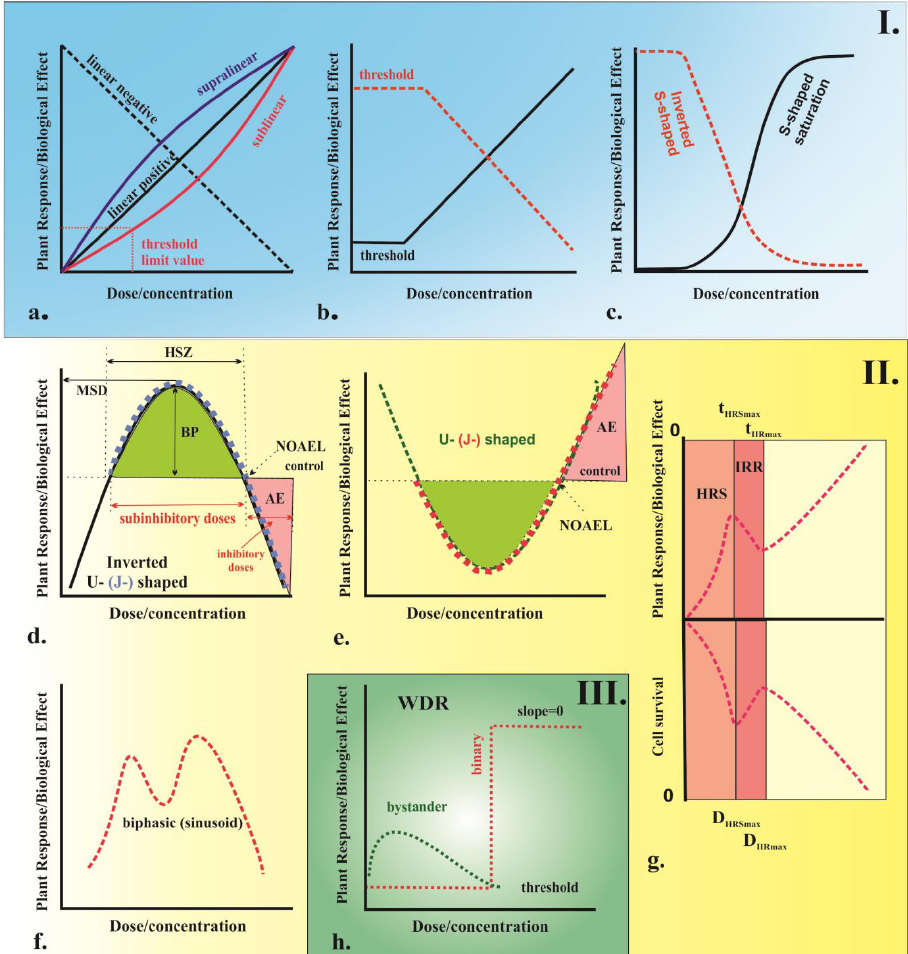
Figure 4. Hypothetical curves of the dose – response relationship. I. Monotonic type (blue background). ( a ) Linear, sublinear and supralinear curves with no clear threshold. The lowest dose at which an effect can be observed is named the threshold limit value (TLV); ( b ) threshold curves; ( c ) S-shaped curves (saturation curve). The S-shaped curves are characterized by an increasing trend, reflecting the beneficial effects on the plant organism as the dose/concentration gradually increases. II. Non-monotonic (yellow background). ( d ) U-shaped or J-shaped curves; ( e ). inverted U- or β - shaped curves. This type of curve reflects the hormetic response at low doses; ( f ) biphasic curve; ( g ) N-shaped dose – response curves of HRS/IRR response in terms of DSBs and cell survival (adapted from Thomas et al. [104] and Devic et al. [105]). III. Curves without dose – response relationship (WDR) (green background). ( h ) Binary curve and bystander response (adapted from Prise and O’Sullivan